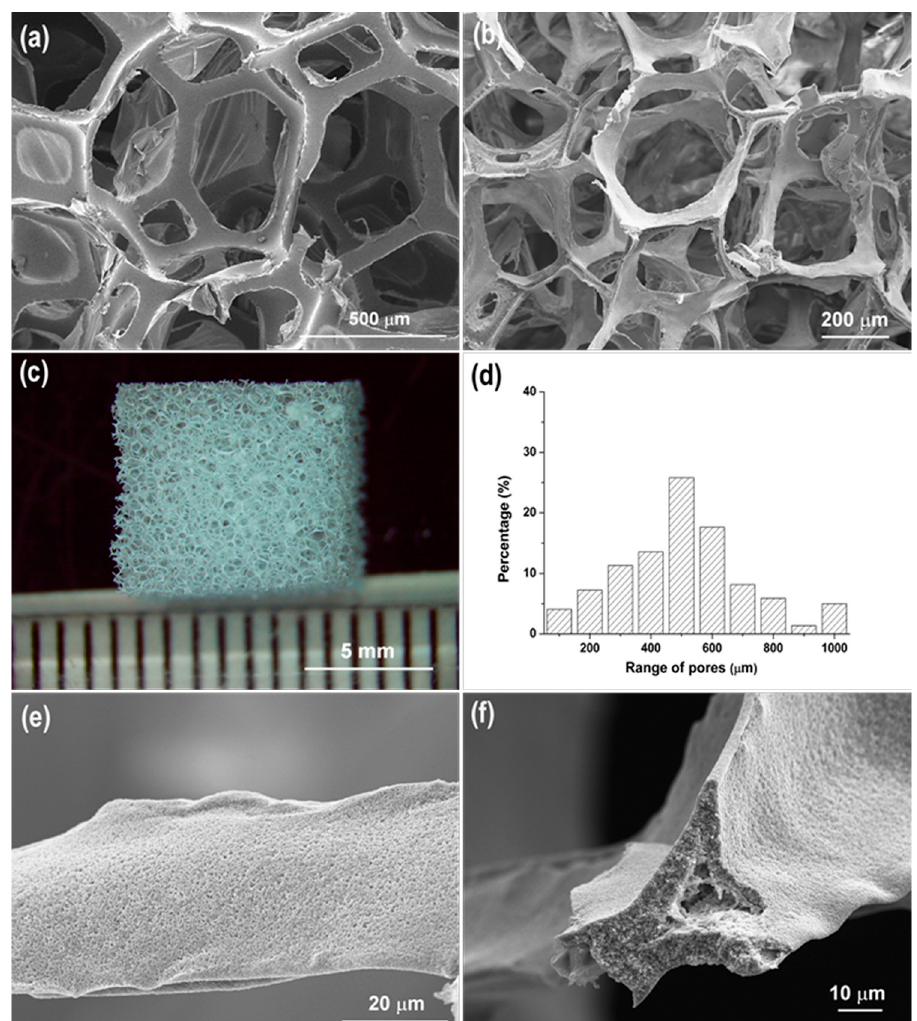
Figure 1. ( a ) SEM image of the PU foam; ( b ) SEM image of the HHA scaffold; ( c ) optical images of the HHA scaffold; ( d ) Pore size distribution of HHA scaffold, corresponding to the large pores form PU template; ( e ) SEM images of the porous structure of a strut; ( f ) cross-section of a strut.